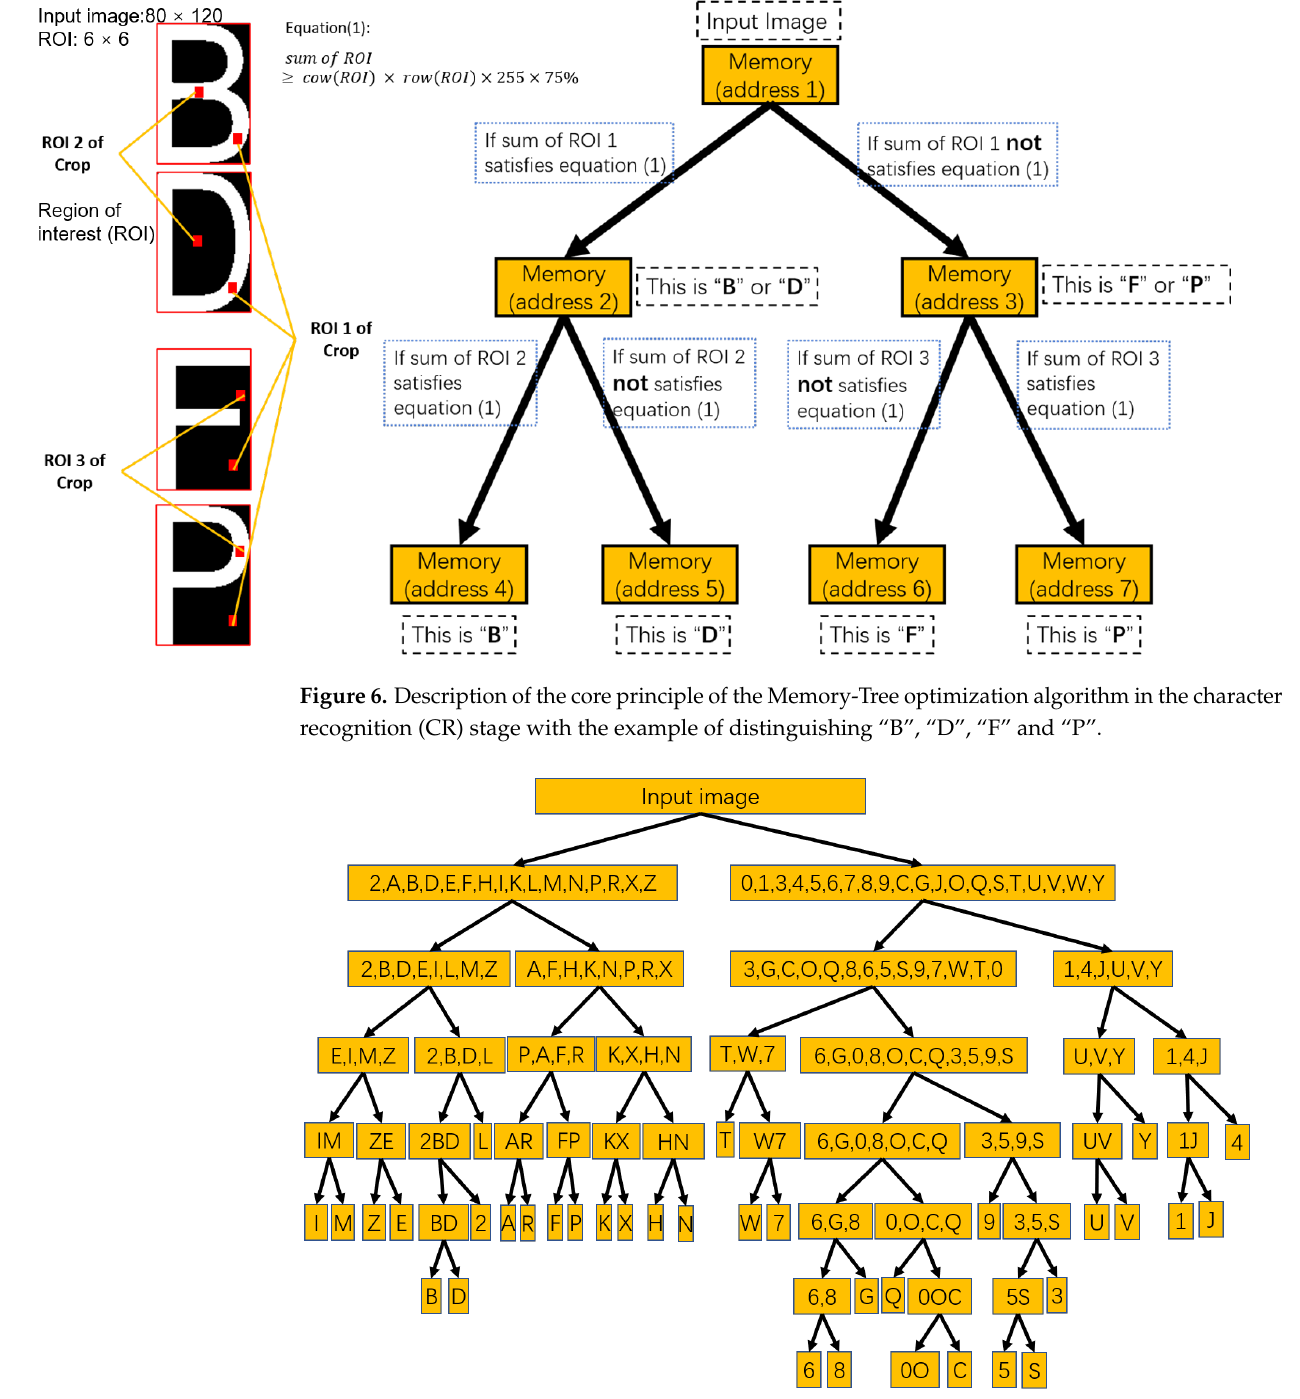
Figure 7. The architecture of the Memory-Tree algorithm applied for the recognition of 35 characters, including numbers and English capital letters. Note that “O” and “0” are considered as the same character because they are too